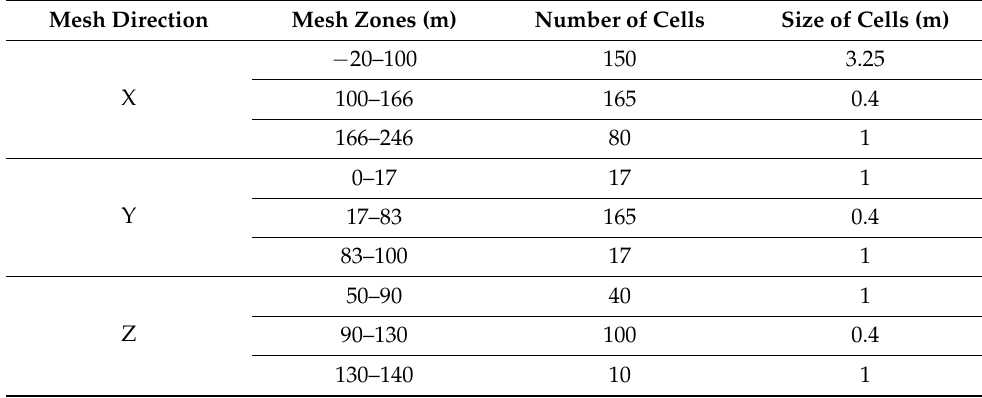
Table 2. Parameters of the ocean waves in hydrodynamics